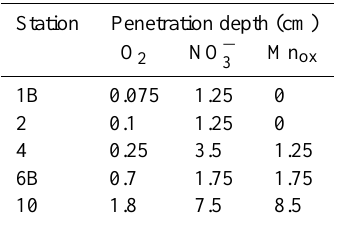
Table 7. Penetration depths of pore-water O 2 , NO − and solid-phase 3 Mn oxides. For O 2 and NO − , the penetration depth was defined as 3 the depth at which the result was a zero reading or a stable back- ground value around the detection limit (0.05µmoll − 1 ), respec- tively. For Mn oxides (Mn ox ), penetration depth was taken as the depth where total solid-phase Mn decreased to a stable background value, likely in the form of Mn